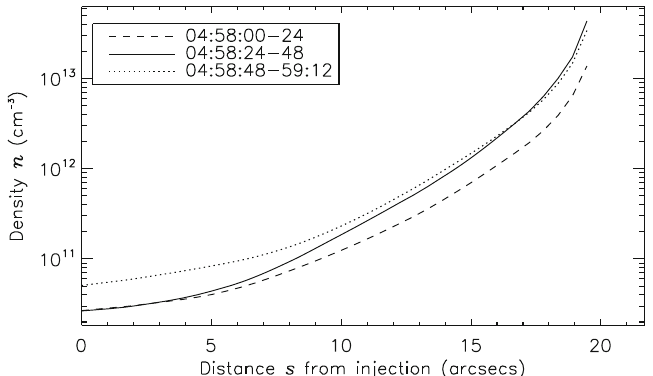
Fig.14 Averageddensityprofilealongaloopversusdistancemeasuredfromthetop.Thedensityisinferred from the location of the hard X-ray emission in the flare loop that is very dense so that the footpoints moved up into the corona in the course of time (given in the inset ). Note the increase in density between the first profile ( dashed ) and last profile ( dotted ). The solid curve represents a time in between. It indicates that the loop fills up from the bottom to the top (i.e., from high density to low density). Image reproduced with permission from Liu et al. (2006), copyright by